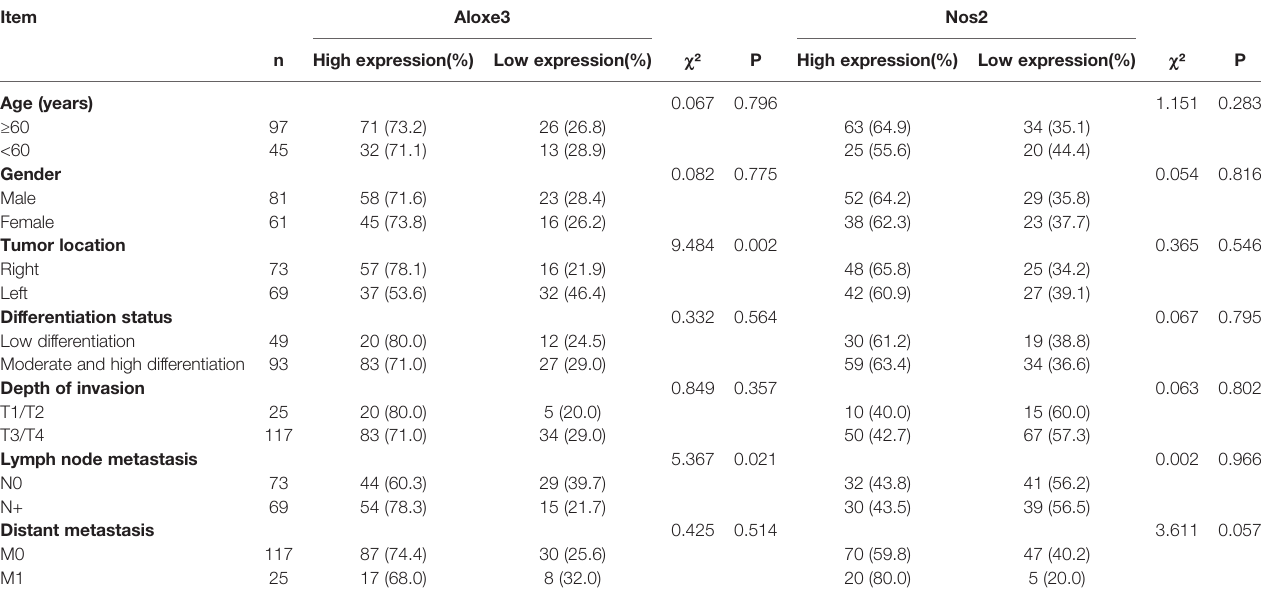
TABLE 2 | Correlation between NOS2, ALOXE3 expression levels and clinicopathological characteristics of patients with colon